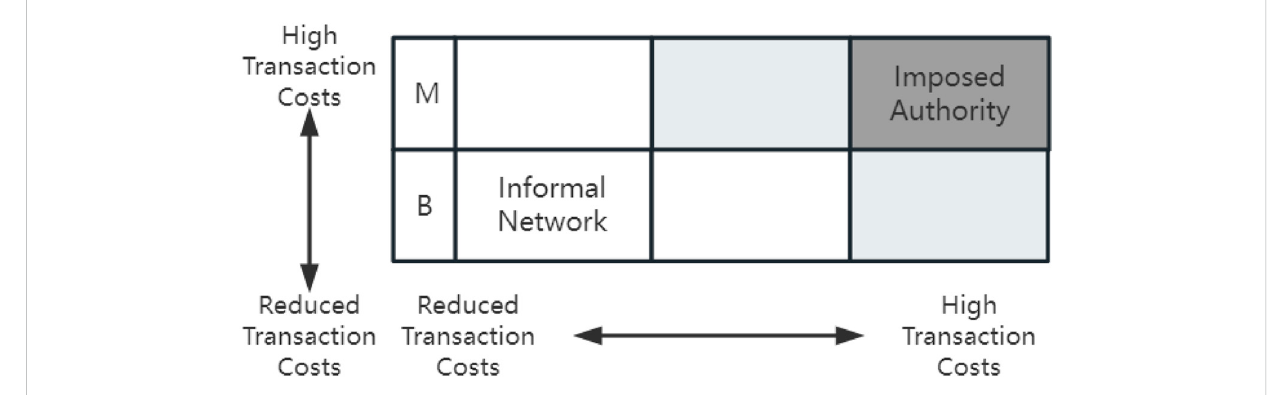
FIGURE 1 The theoretical basis for frontline government